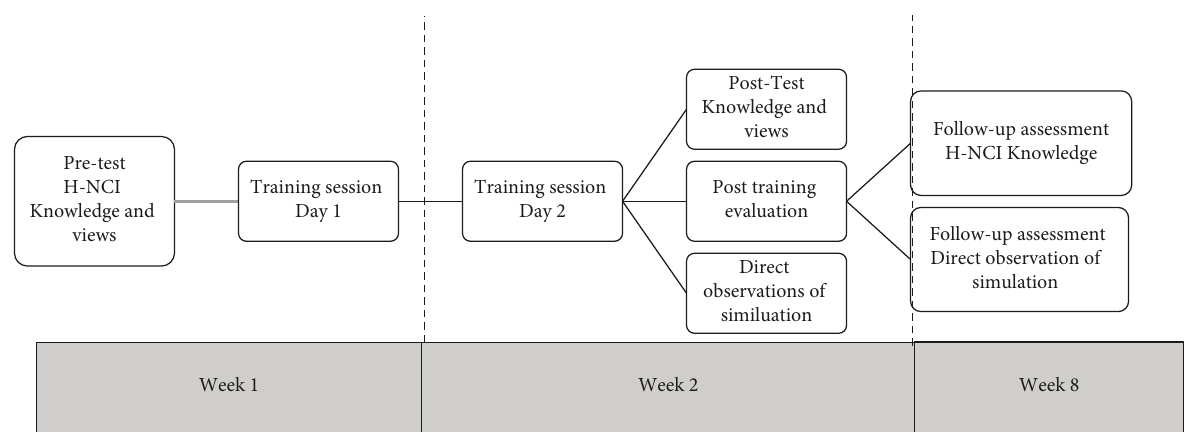
Figure 1: Flow diagram of HIV-associated NCI training and